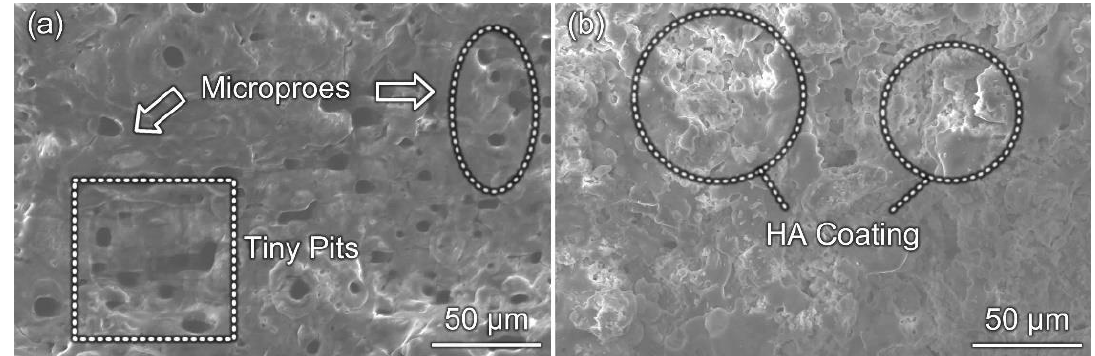
Figure 2. Morphologies of coatings: ( a ) surface morphology of MAO coating; ( b ) surface morphology MAO/APS coating.